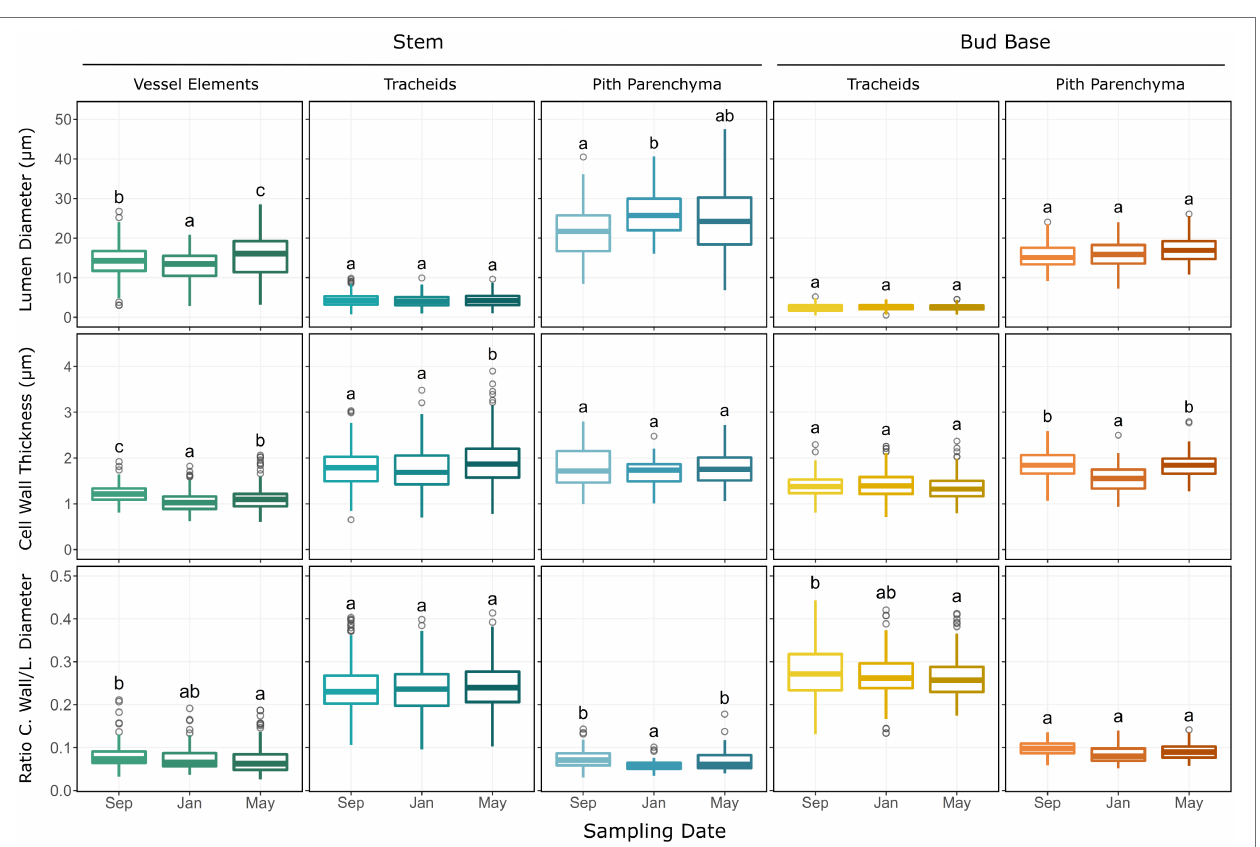
FIGURE 5 | Histological parameters measured on transverse sections of Vaccinium macrocarpon terminal buds in the bud base and stem. Each plot depicts boxplots for each of the sampling dates. Each column represents a particular cell type or tissue, sub-grouped by stem and bud base. Rows represent the measured parameter. Whiskers represent the interquartile range 1.5-fold, while outliers are represented as gray rings. Lower case letters represent significant difference among the means in each